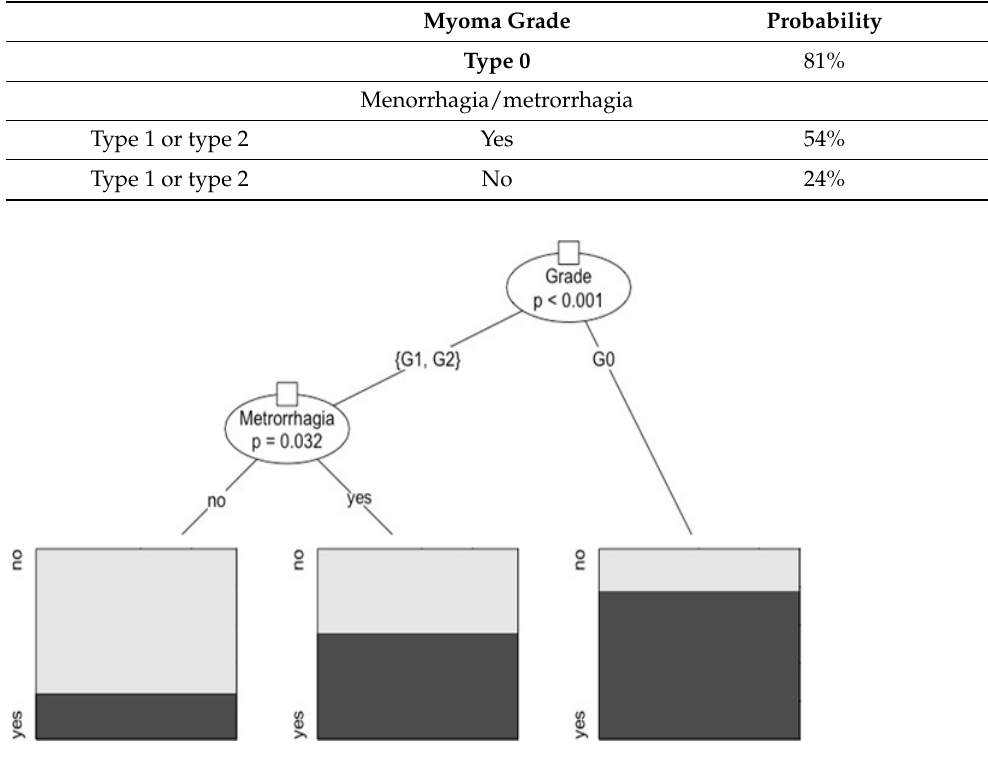
Figure 1. The regression tree depicting the relation between anemia and its statistically significant predictors, i.e., grade and menorrhagia/metrorrhagia. In the patients with myoma type 0, there is a possibility of 81% having anemia regardless of menorrhagia/metrorrhagia. In the patients with myomas type 1–2, the possibility of having anemia varies according to the presence or absence of menorrhagia: in the former case, the possibility is estimated at 54%, while in the latter case, the possibility decreases to 24%.